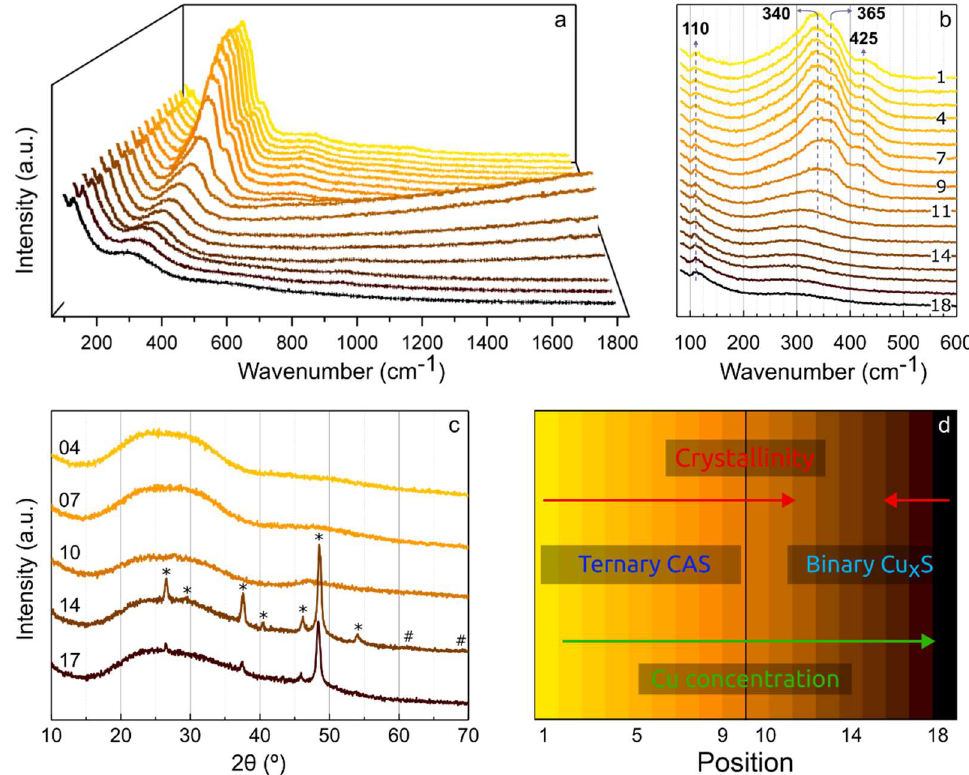
Figure 3. ( a , b ) Raman and ( c ) GIXRD (Omega = 1°) spectra of several points measured along an as-deposited 20 × 10 cm thin-film with variable atomic concentrations of Cu, As and S. Position 1 and 18 are the furthest from and closest to the Cu target, respectively, as depicted in Figure 1. ( d ) Representation of the main material attributes of the deposited thin-films.